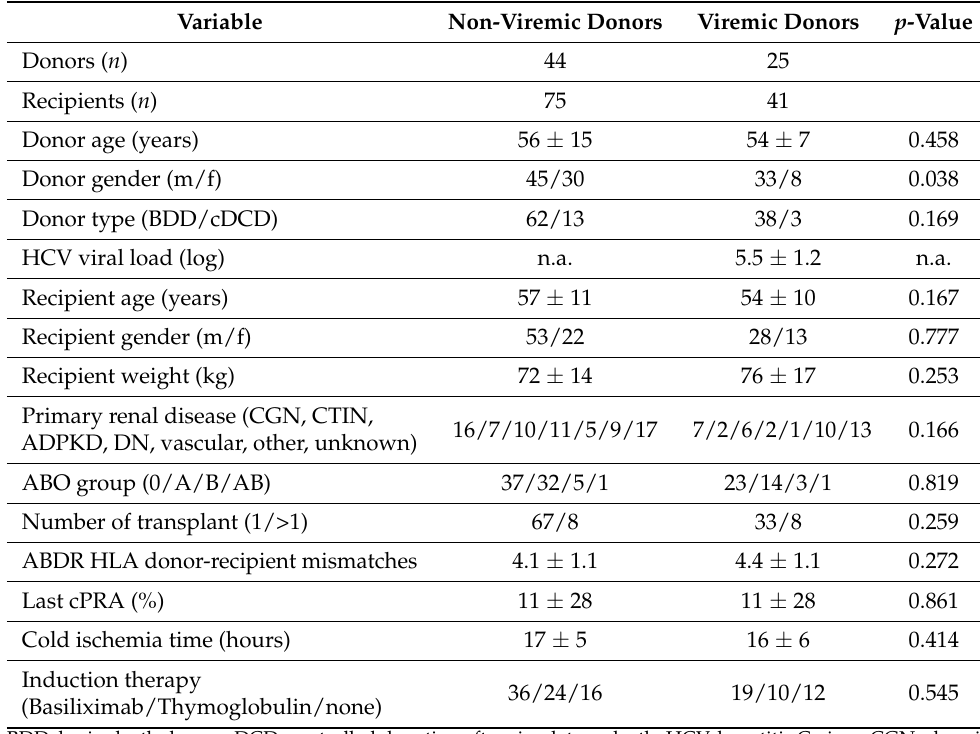
Table 1. Donor and recipient demographics and transplant-related variables among transplants performed with hepatitis C virus positive non-viremic and viremic